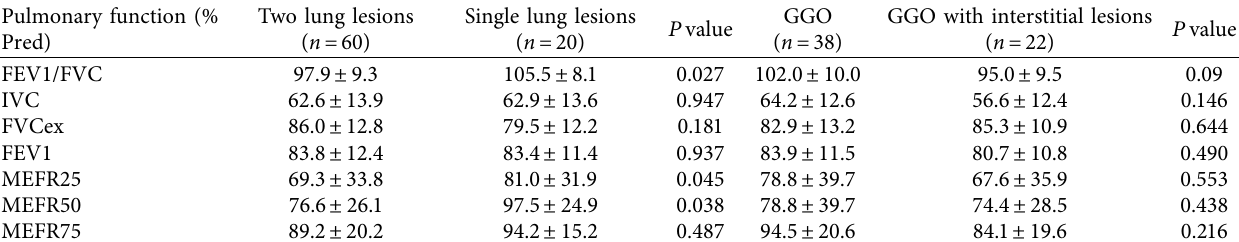
Table 5: Correlation between pulmonary function and pulmonary imaging at discharge.